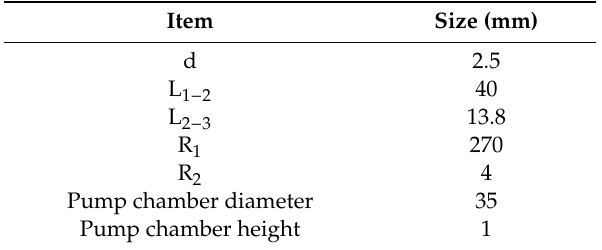
Figure 2. The streamlined flow tube valveless piezoelectric (SLFT PZT) pump. Table 1. The size of the SLFT PZT pump.